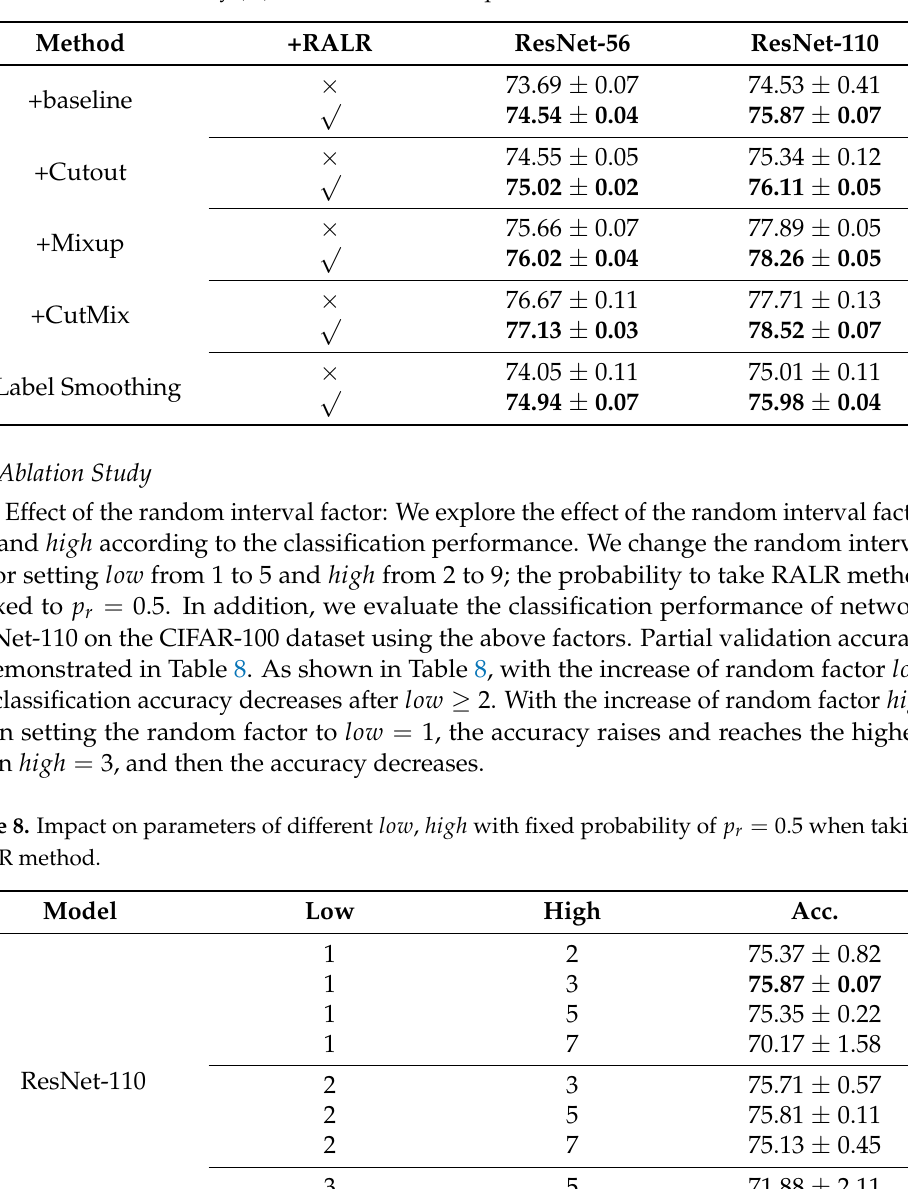
Table 7. Validation accuracy (%) over different techniques based on ResNets trained on CIFAR-100.